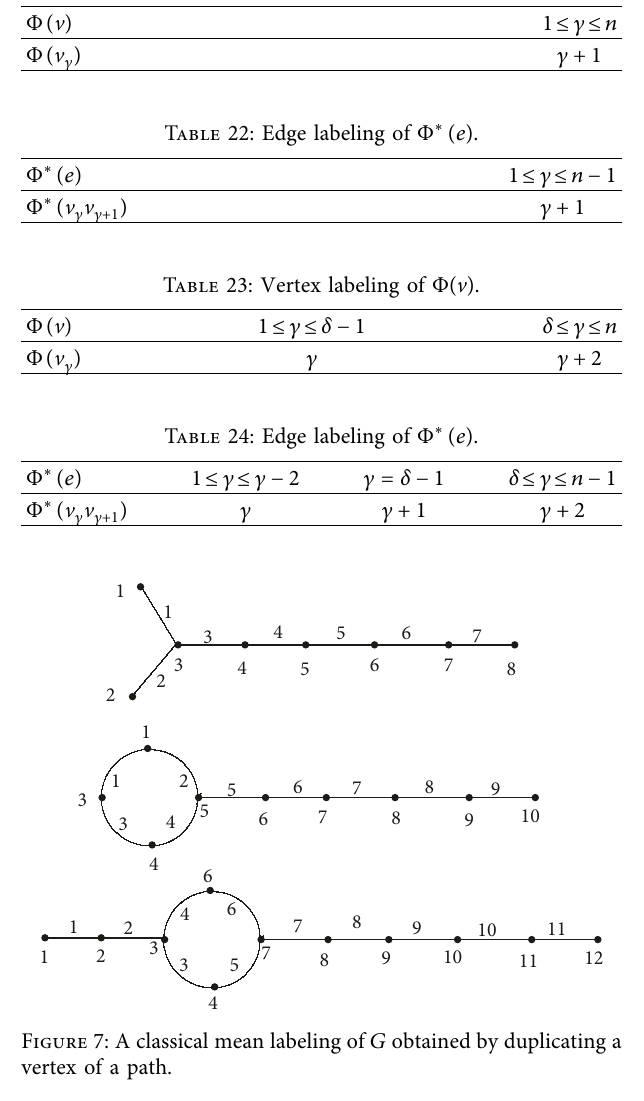
Table 25: Vertex labeling of Φ ( v ).